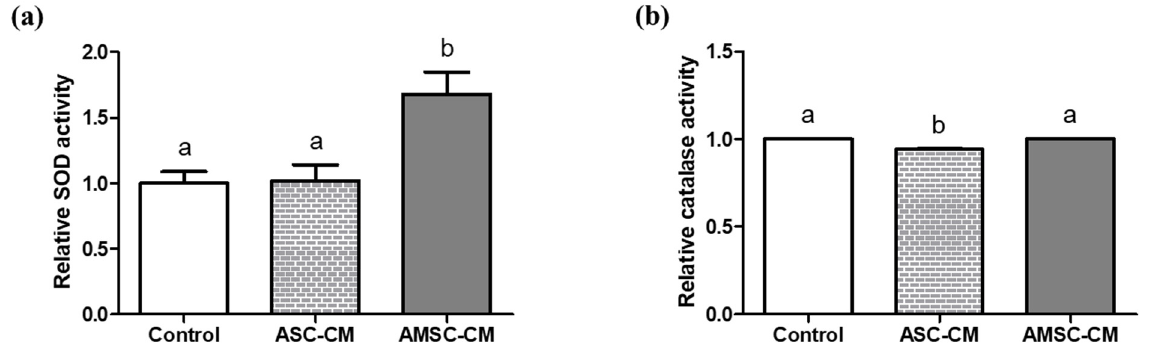
Figure 6. Comparison of antioxidant biomarker levels in culture medium supplemented with human adipose-derived mesenchymal stem cell conditioned medium (ASC-CM) and amniotic membrane-derived mesenchymal stem cell conditioned medium (AMSC-CM) which was collected after 5 days of embryo culture. ( a ) Superoxide dismutase (SOD) and ( b ) catalase activity. Data are normalized to average value of control and presented as the mean ± SEM. Superscript letters in each column indicate significant differences ( p < 0.05).